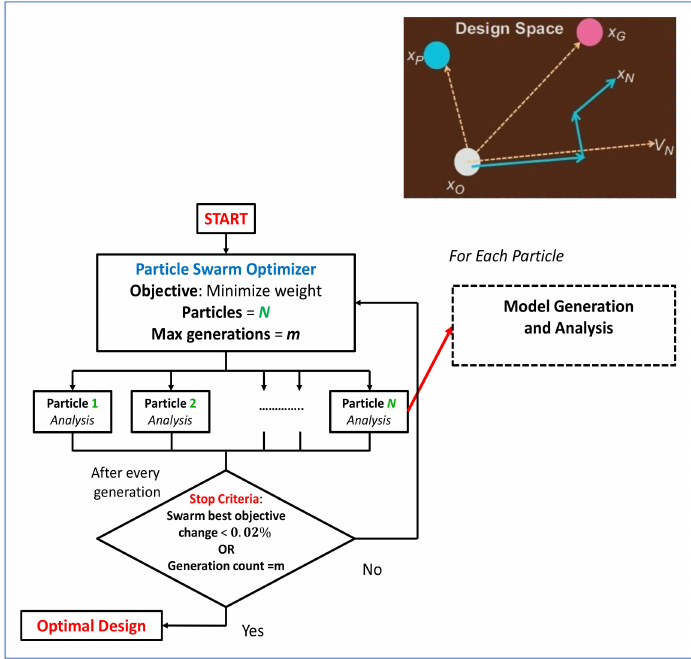
Figure 12. PSO algorithm applied to the weight minimization